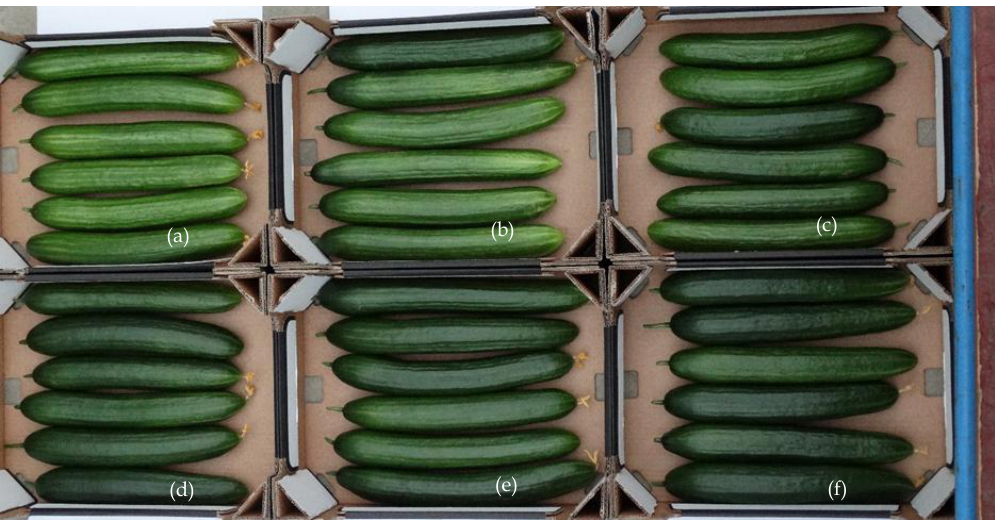
Figure A4. Cucumbers harvested, pictures of fruits from different compartments of teams: ( a ) The Croperators; ( b ) Sonoma; ( c ) AiCU; ( d ) Reference; ( e ) deep_greens; ( f ) iGrow.